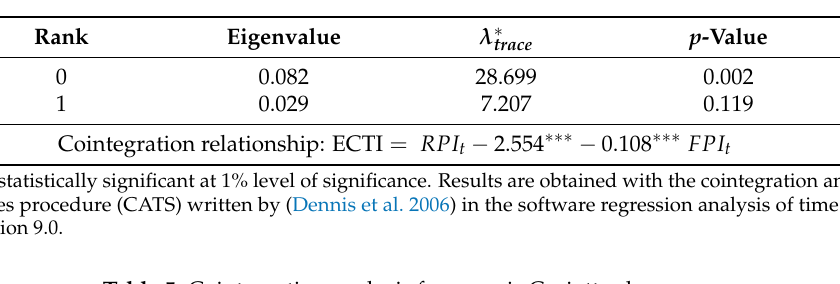
Table 5. Cointegration analysis for generic Caciotta